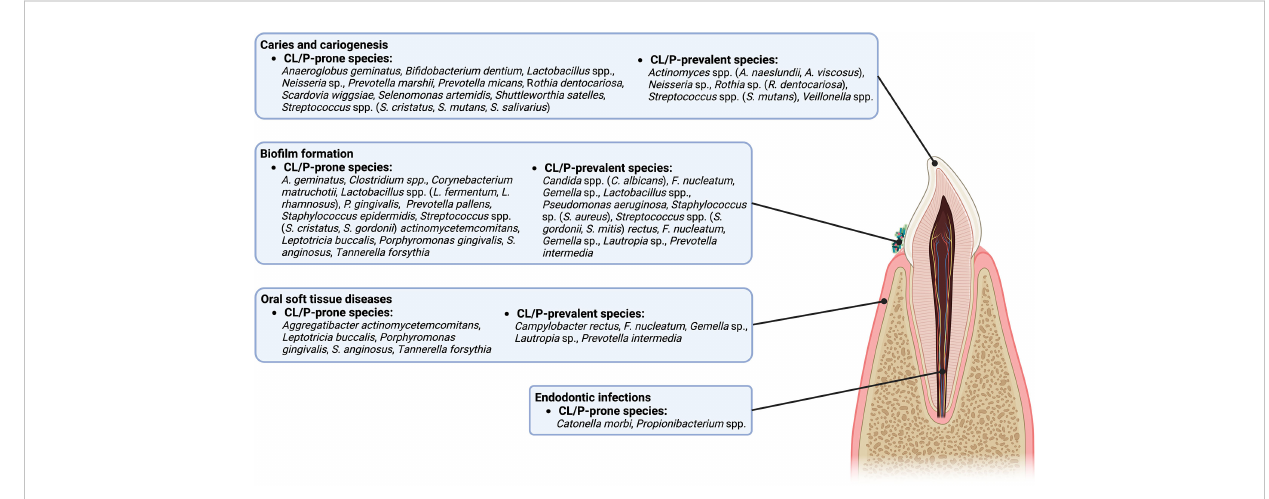
FIGURE 1 A diagram of the intraoral anatomic structures that are potentially in fl uenced by CL/P-prone and CL/P-prevalent